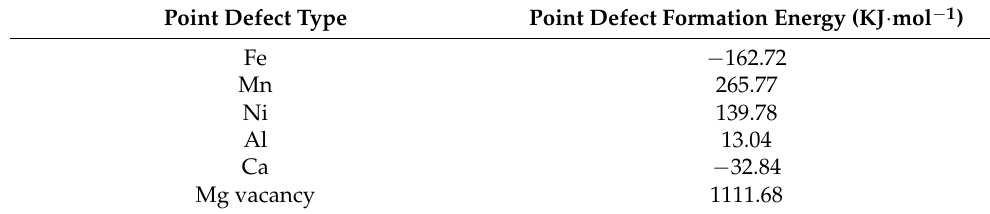
Table 1. Point defect formation